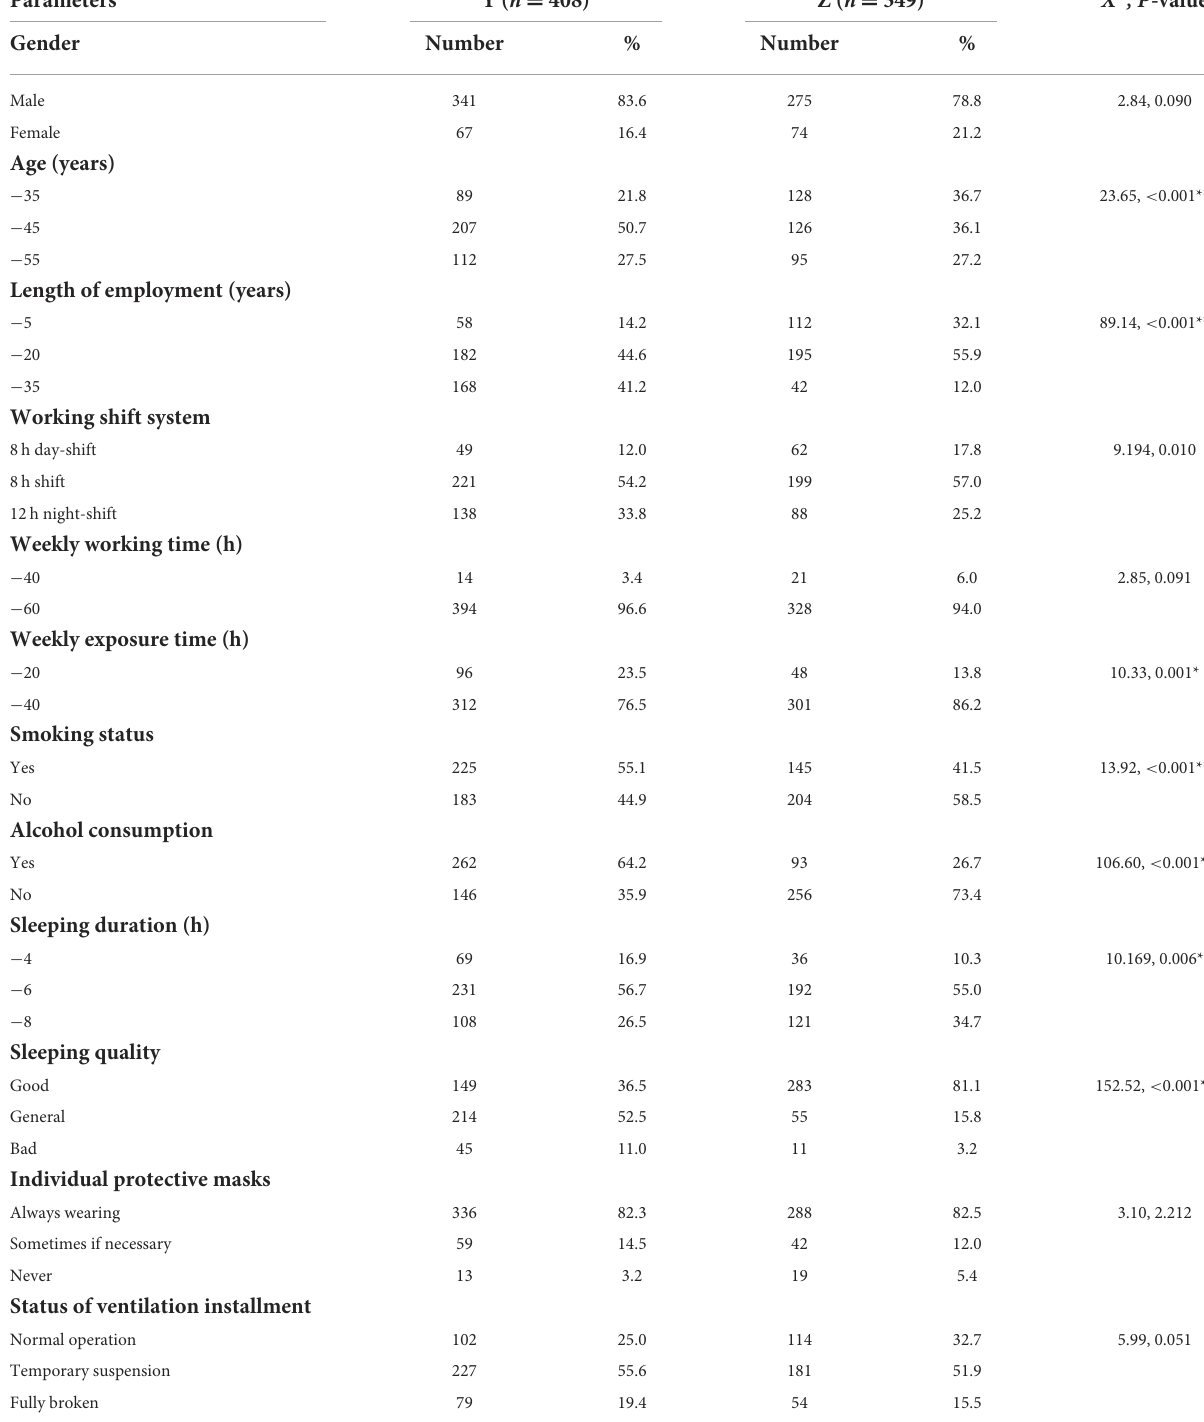
TABLE 2 Comparison results of questionnaires between Y and Z in